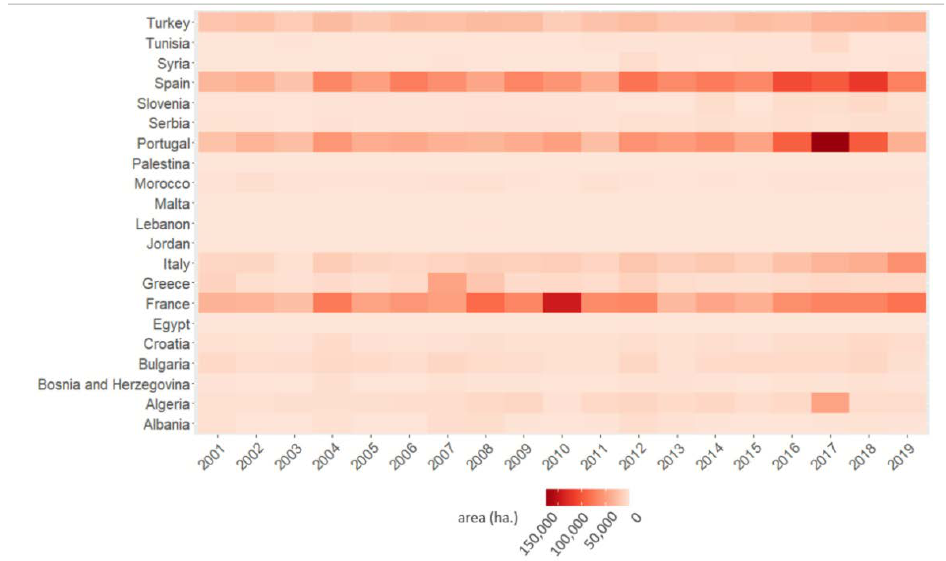
Figure 3. Tree cover loss by country (2001–2019).